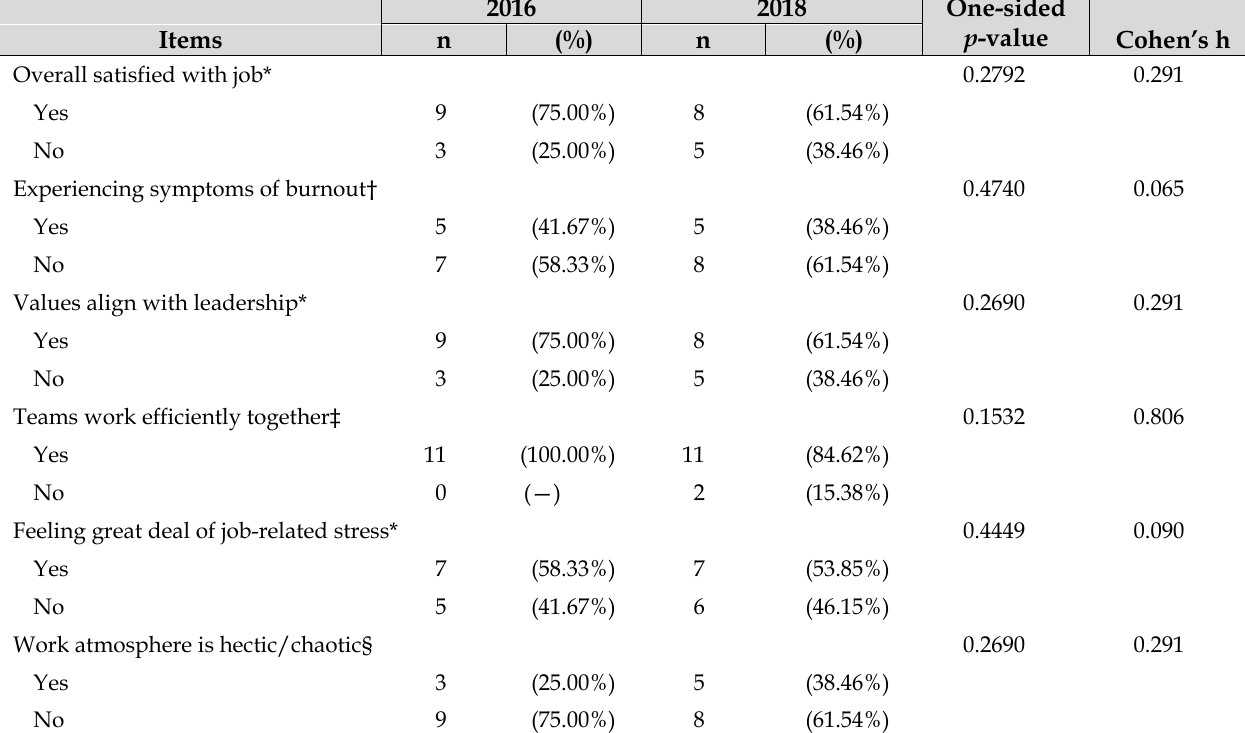
Table 2 Comparison of American Medical Association (AMA) Mini-Z items for faculty between 2016 and